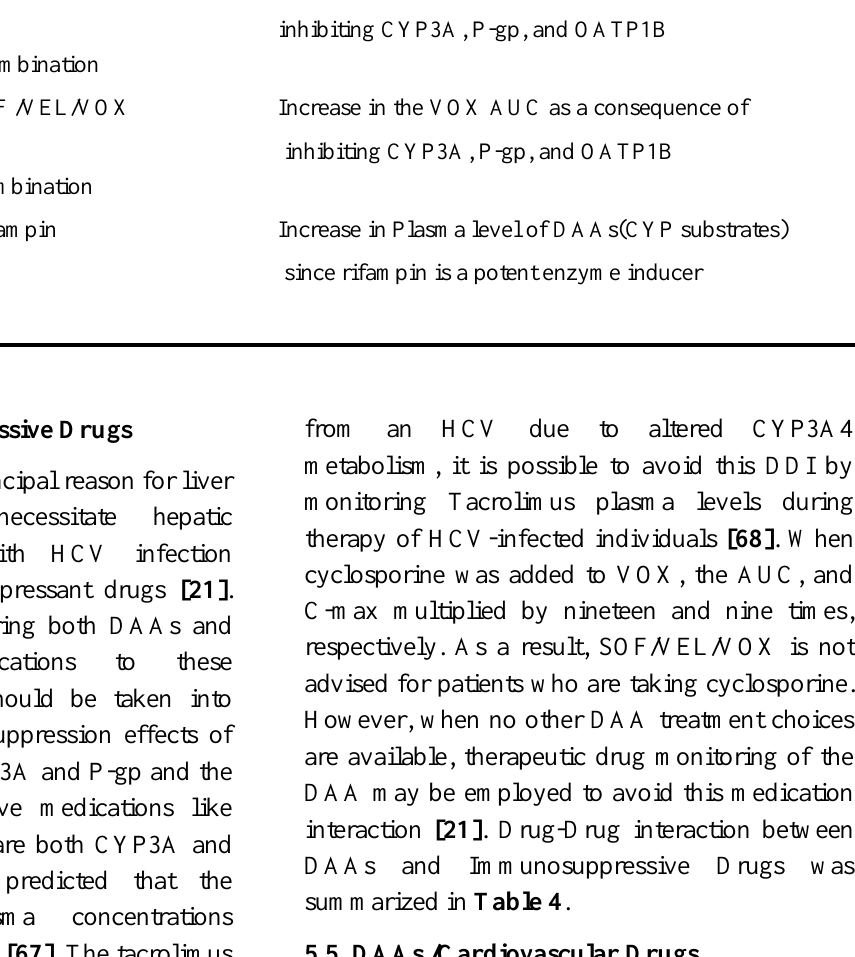
Table 3. Drug-Drug interactions between DAAs and HIV Drugs DAAs HIV Drugs Drug-Drug Interaction VEL, BOC, and telaprevir Efavirenz AUC of DDAs was reduced almost by 50% DCV Atazanavir/Ritonavir Increase in DCV plasma levels Darunavir/ritonavir SOF /VEL/VOX Increase in VOX AUC as a consequence of inhibiting CYP3A, P-gp, and OATP1B Combination Atazanavir/ritonavir SOF /VEL/VOX Increase in the VOX AUC as a consequence of inhibiting CYP3A, P-gp, and OATP1B Combination DAAs (CYP substrates) Rifampin Increase in Plasma level of DAAs(CYP